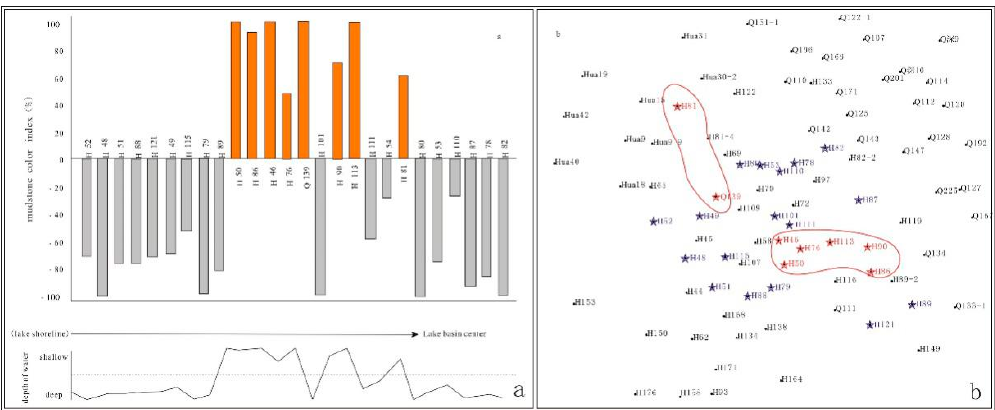
Figure 6. Mudstone Color Values of Sand Group V in Qiang-2 Member. ( a ) A diagram for water depth interpretation based on the analysis of mudstone color values; ( b ) A well position map (the asterisk is for the well in Figure 6a).